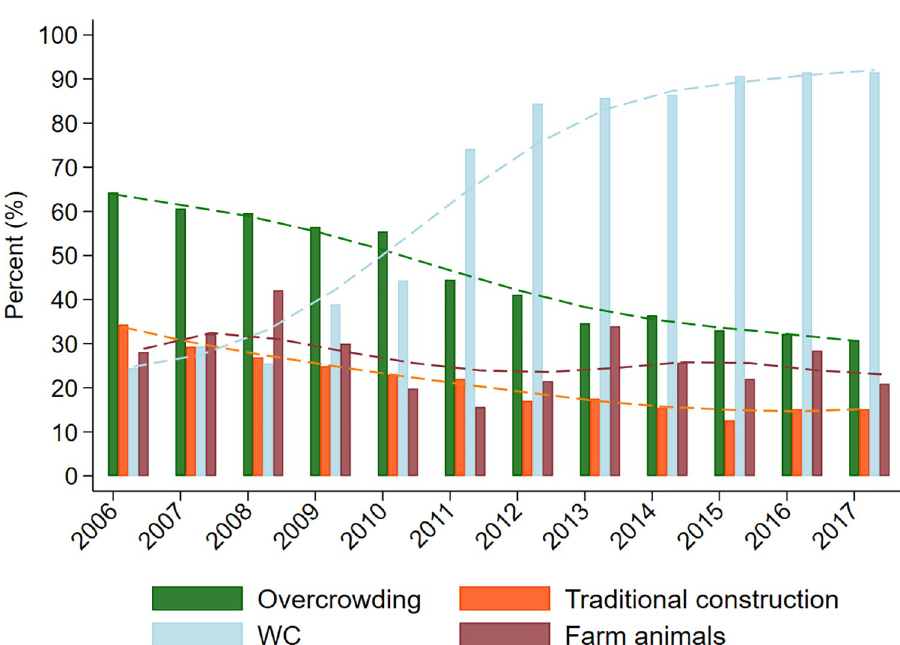
Fig 7. Temporal changes in household characteristics during recruitment and follow-up of cohort between 2006 and 2017. Overcrowding— > = 3 persons /sleeping room; traditional construction–wood and or bamboo walls; WC– water closet connected to municipal sewage or septic tank; farm animals–any large farm animal around the household. Number of households providing data by year: 2006 (431 households); 2007 (996); 2008 (1709); 2009 (2229); 2010 (1893); 2011 (1707); 2012 (1019); 2013 (841); 2014 (623); 2015 (540); 2016 (571); and 2017 (578). Household data were collected when the child was aged 0, 7, 13, 24, 36, 60, and 96 months and could provide data a maximum of once in any calendar year. Poly.—empirical polynomial lowess smoothing with suggestive trends across calendar